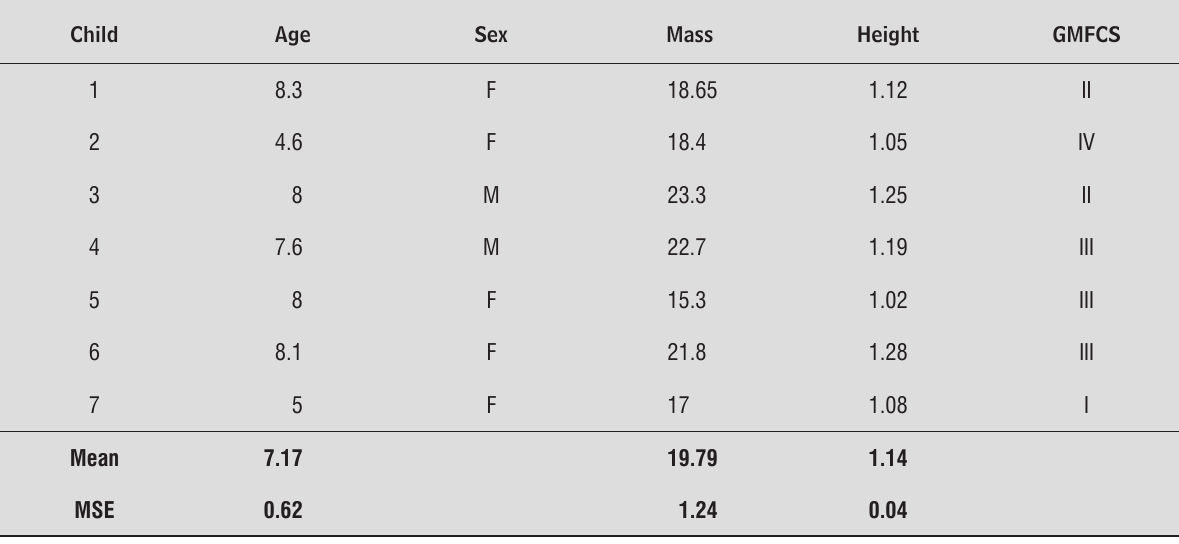
Table 1 - General characteristics about the children with spastic cerebral palsy that participated in the study in terms